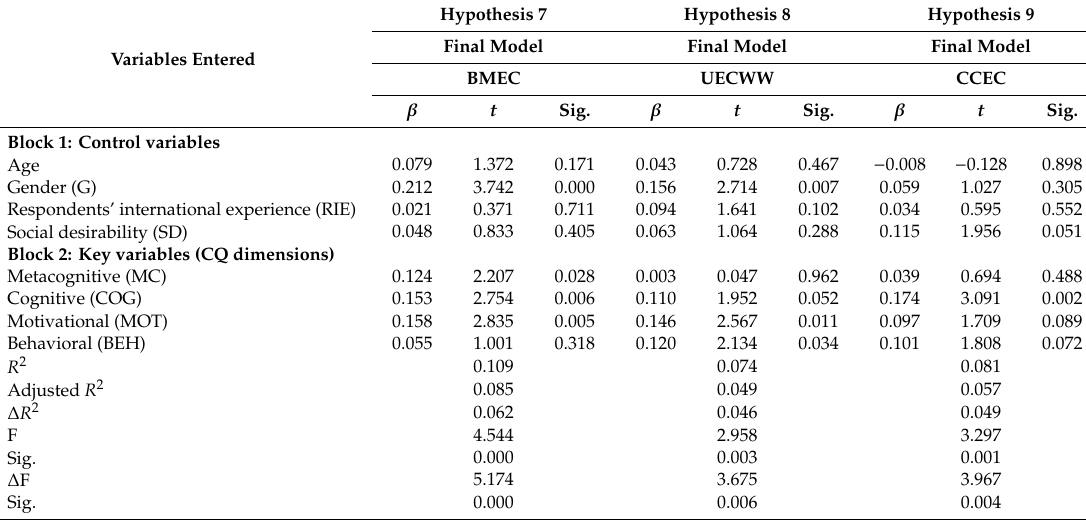
Table 7. Regression results (H7, H8, and H9).